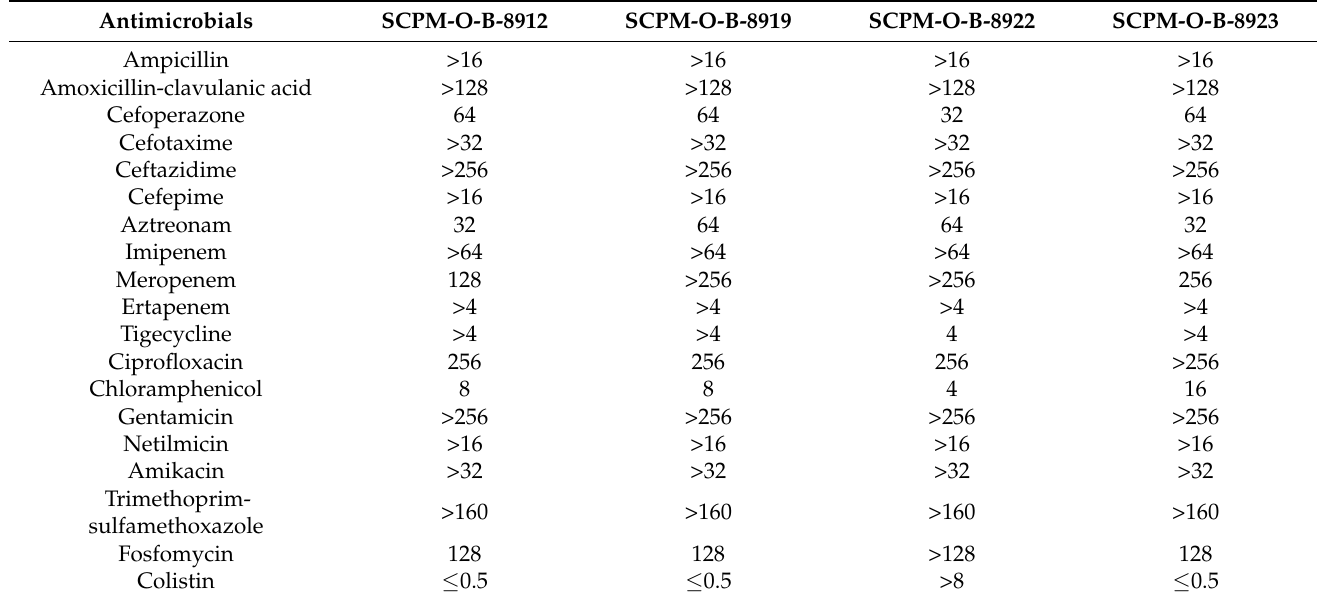
Table 2. Antimicrobial susceptibility of K. pneumoniae strains (MIC,